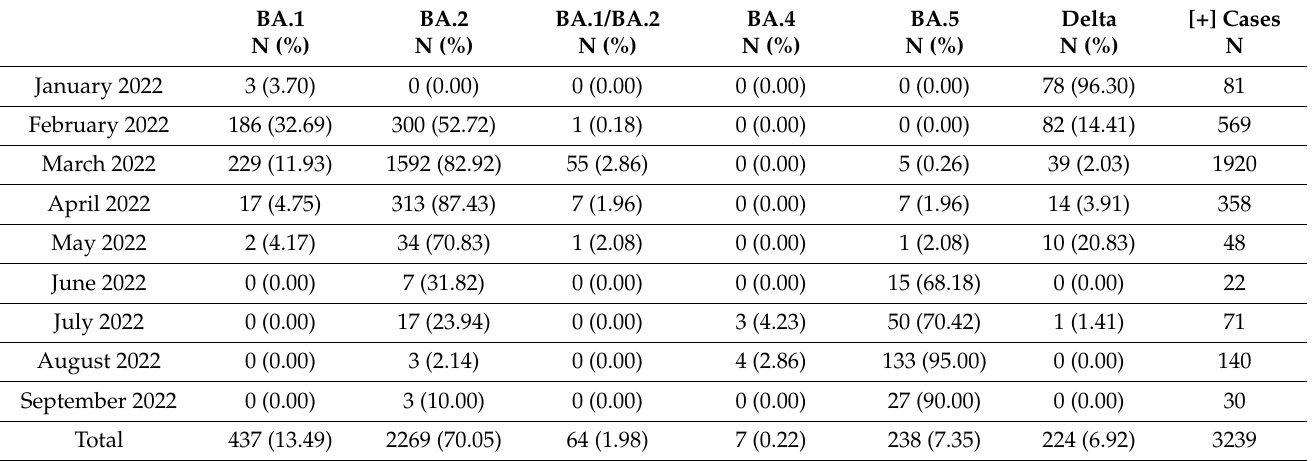
Table 4. The distribution of the SARS-CoV-2 variants detected by the MPL RT-rPCR among 3239 SARS-CoV-2 [+] samples collected from January to September